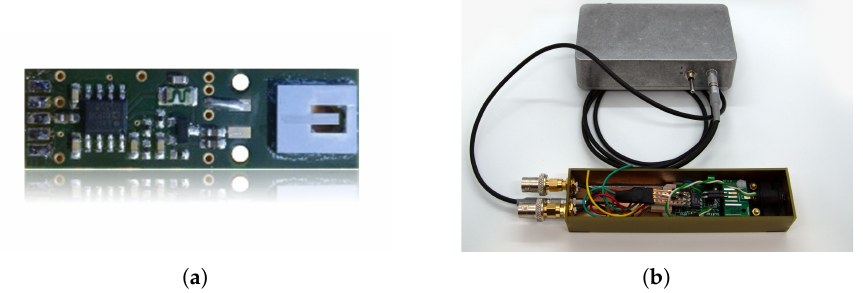
Figure 10. Sensors systems used in this study: In ( a ) an exchange bias magnetoelectric sensor is shown with integrated readout electronics. In ( b ) an electrically modulated ME sensor is presented with integrated preamplifier and external shielded battery supply (gray box; magnetoelectric sensor (cantilever) with integrated readout. ( b ) Electrically modulated ME sensor with integrated preamplifier and external